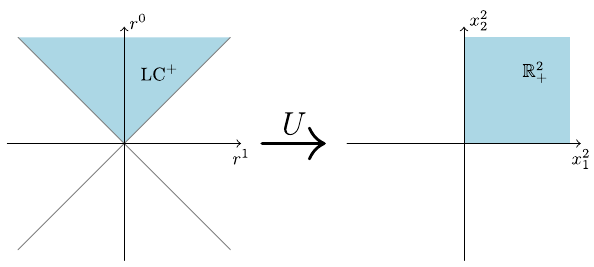
Fig. 2 Rotation of the 1 + 1 forward lightcone LC + into the non- negative quadrant R 2